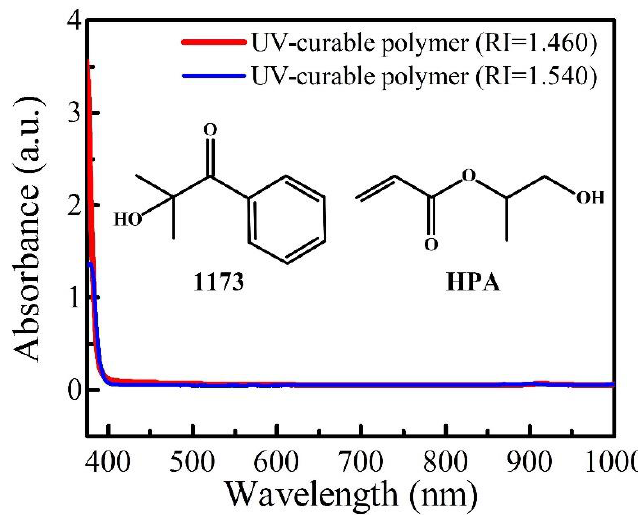
Figure 1. Absorption spectra of the two types of UV-curable polymers used in this work. Table 1. Properties of different types of polymers. Polymer TOC (RIU/°C) Refractive Index Reference